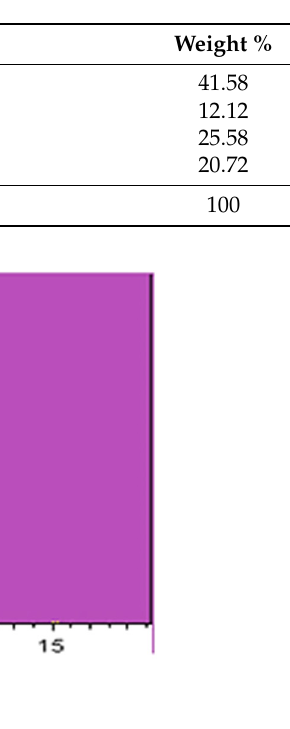
Table 1. Elemental composition for n Si.